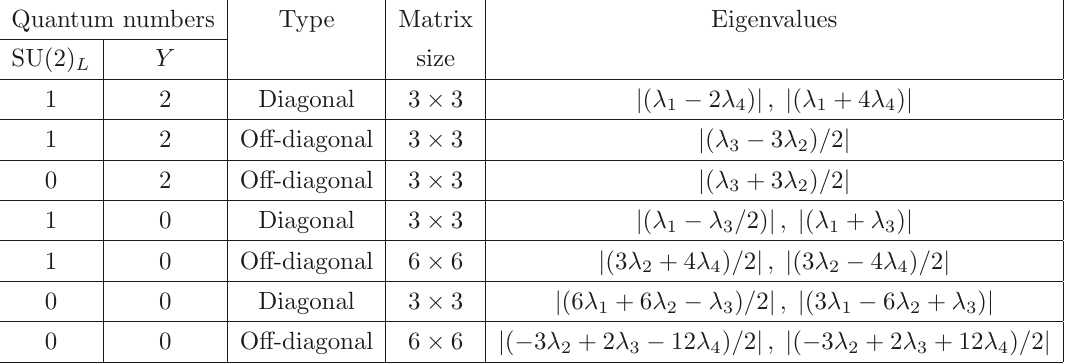
= j ) with i, j = 1 , 2 , 3. 6